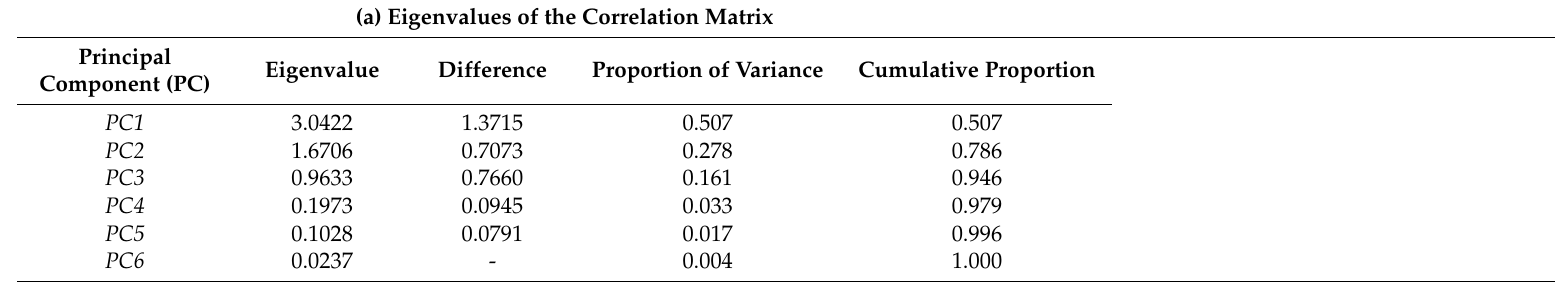
Table A7. Principal Components Analysis (a and b) and the resulting correlation between NEE and Principal Components (c). (a) Eigenvalues of the Correlation